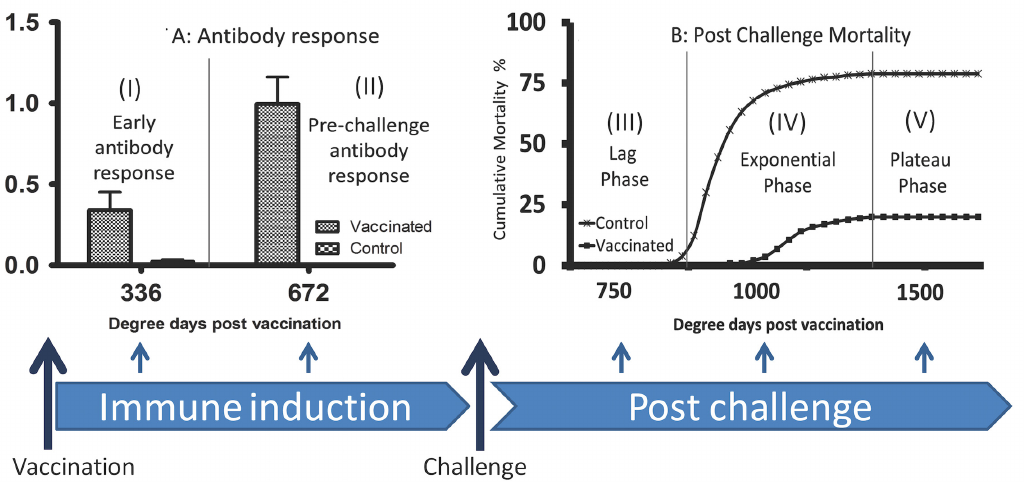
Fig 5. Experimental timing. Sampling time-point established for the cohabitation challenge model segmented into A and B. (A) shows the immune induction period (I and II), between vaccination and challenge, depicting the progression of antibody responses for fish immunized using a commercial vaccine (Pharmaq AS). Note that antibody responses increased by threefold from (I) during the early antibody responses when levels were at 0.326 OD 490 at 330 degree days (dd) to (II) pre-challenge antibody responses when levels were at 1.221 OD 490 at 672 dd. (B) shows the post challenge period depicting the progression of cumulative mortality in the vaccinated and control fish. Cumulative mortality for both the vaccinated and control fish progressed in three stages namely (III) lag-phase, (IV) exponential phase, and (V) plateau phase. Blue arrows below show the sampling time-points during immune induction and the post challenge